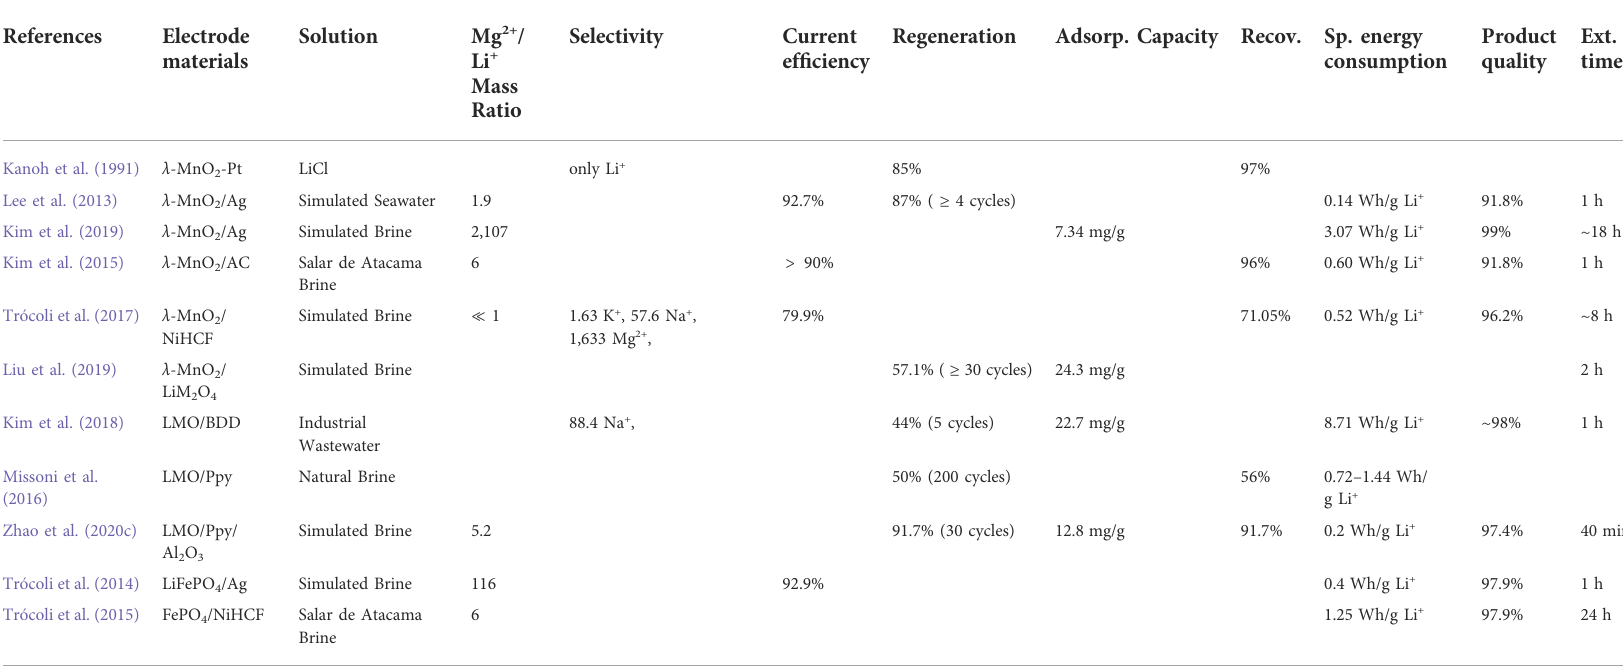
TABLE 9 Li + ESIX (electrode) extraction from salt lake brines, simulated brines, and